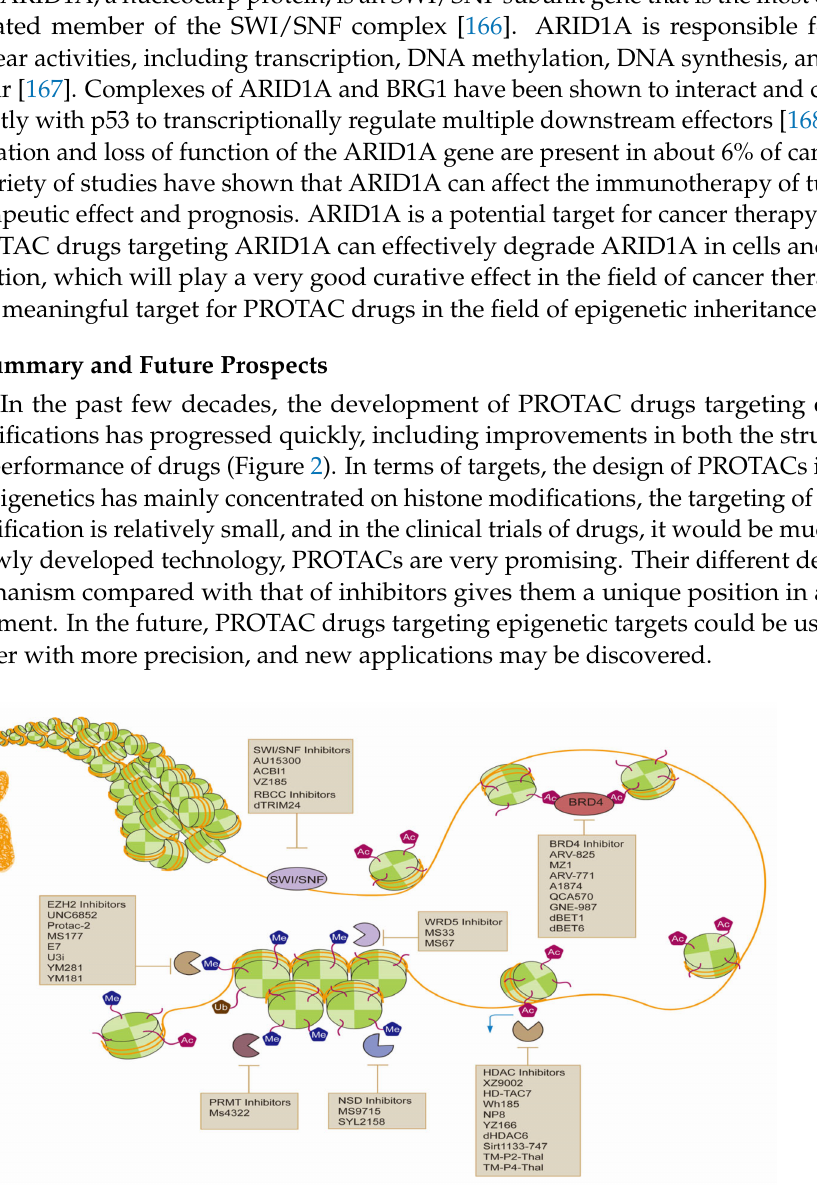
Figure 2. Epigenetic targets in cancer and their PROTA